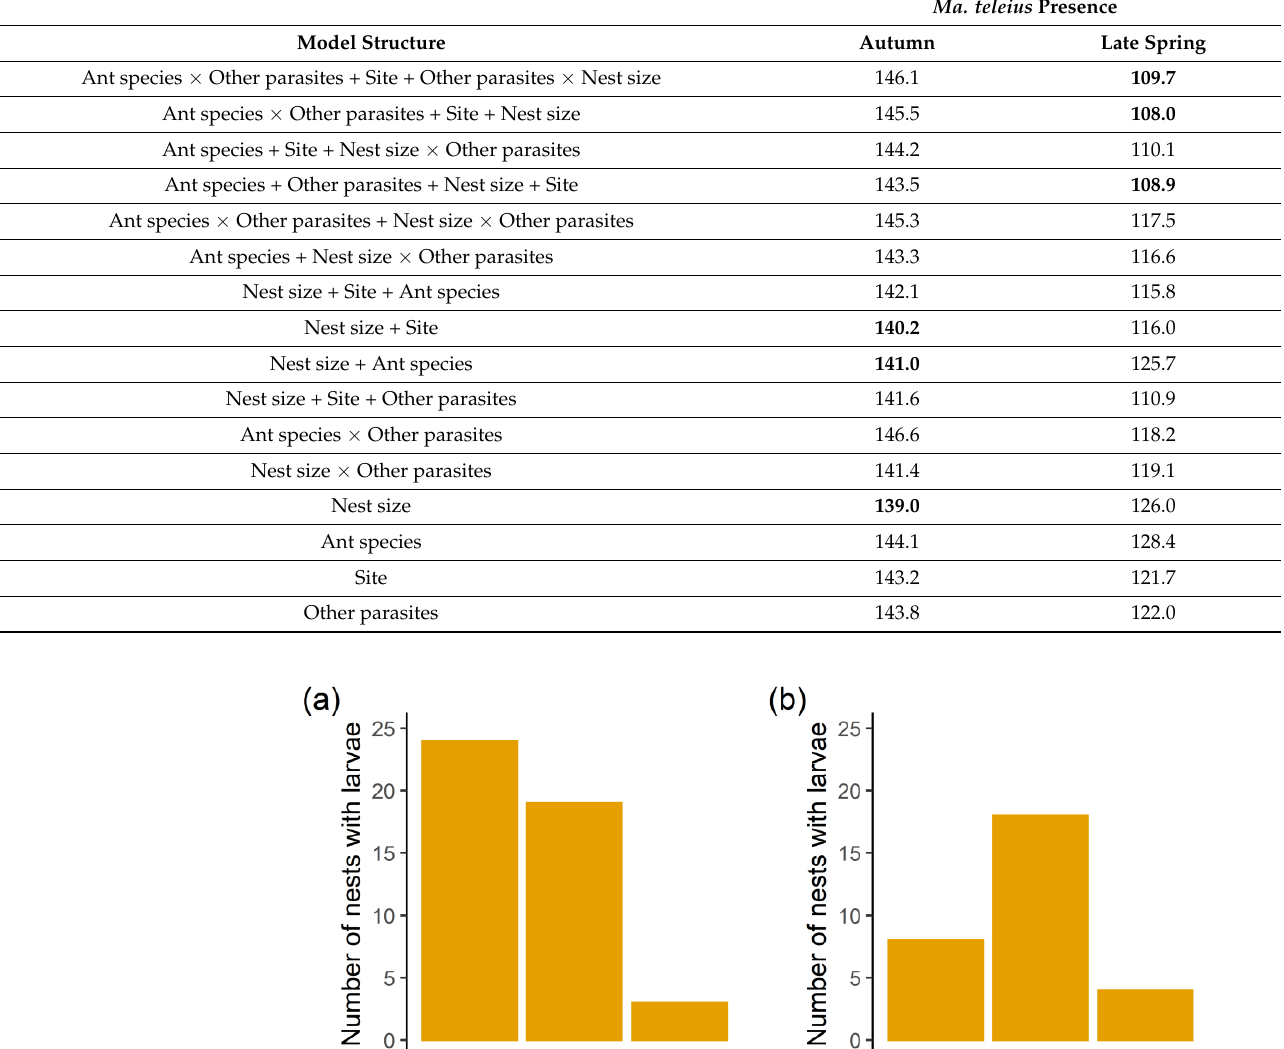
Table 2. AIC values for models with different fixed structures fitted for the two study seasons. The base models relate the presence/absence of Ma. teleius larvae (dependent variable) to all explanatory variables included as fixed effects. Models selected according to information criteria ( ∆ AIC < 2) are in bold.